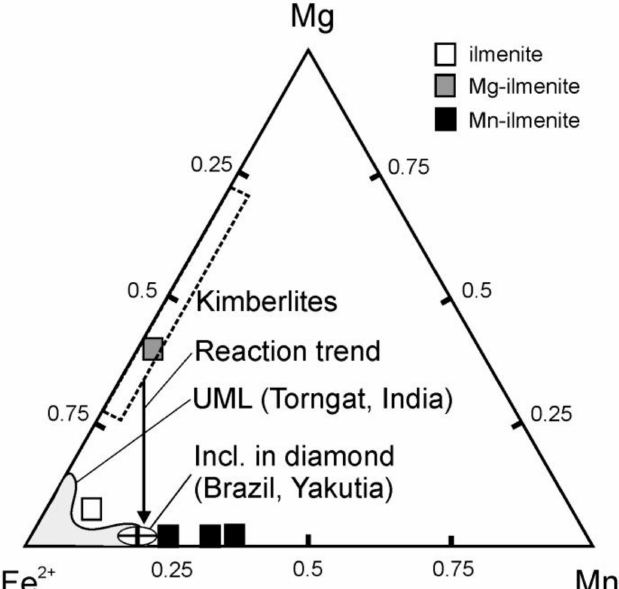
Figure 11. Composition of ilmenite group minerals from Vinoren compared to typical ilmenite from kimberlite [47], UML from Torngat [35], UML from India [57] and as inclusions in diamonds [54,55]. The reaction trend is after